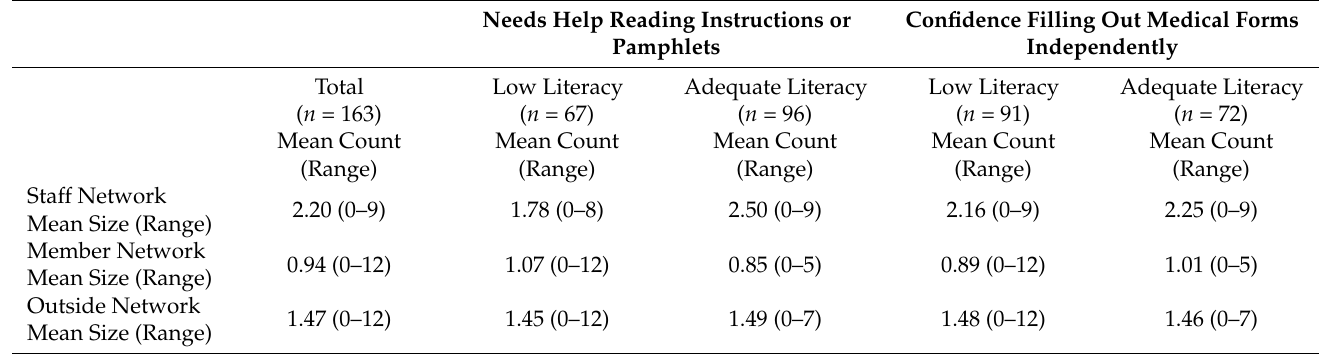
Table 2. Social Network Characteristics and Average Health Literacy.